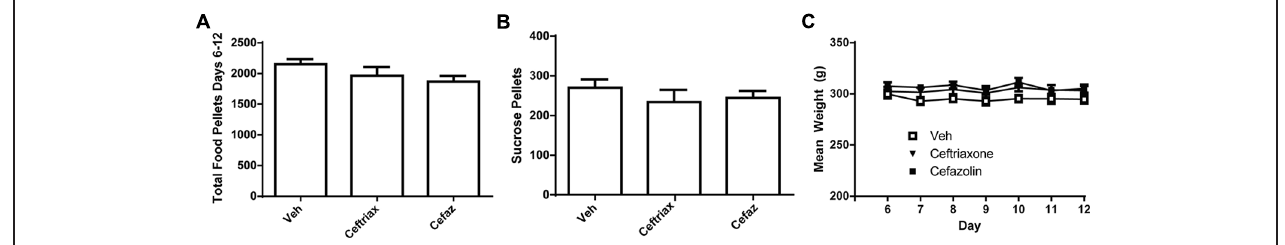
FIGURE 4 | Ceftriaxone and cefazolin did not alter the motivation to self-administer regular chow or sucrose pellets. (A) CEF and CEFAZ did not alter the self-administration of regular chow pellets. (B) CEF and CEFAZ did not alter the mean number of sucrose pellets self-administered. (C) Mean body weight did not differ between vehicle-, CEF- or CEFAZ-treated rats.